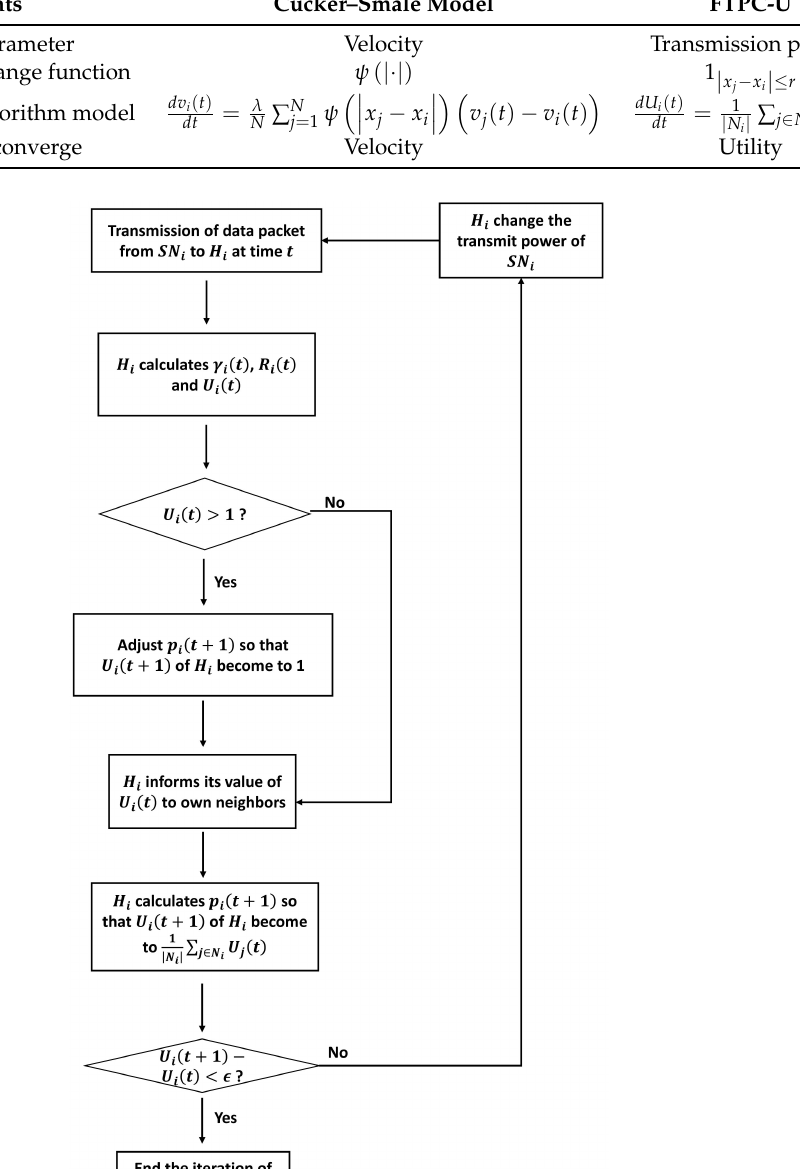
Figure 6. Operational procedure of the proposed